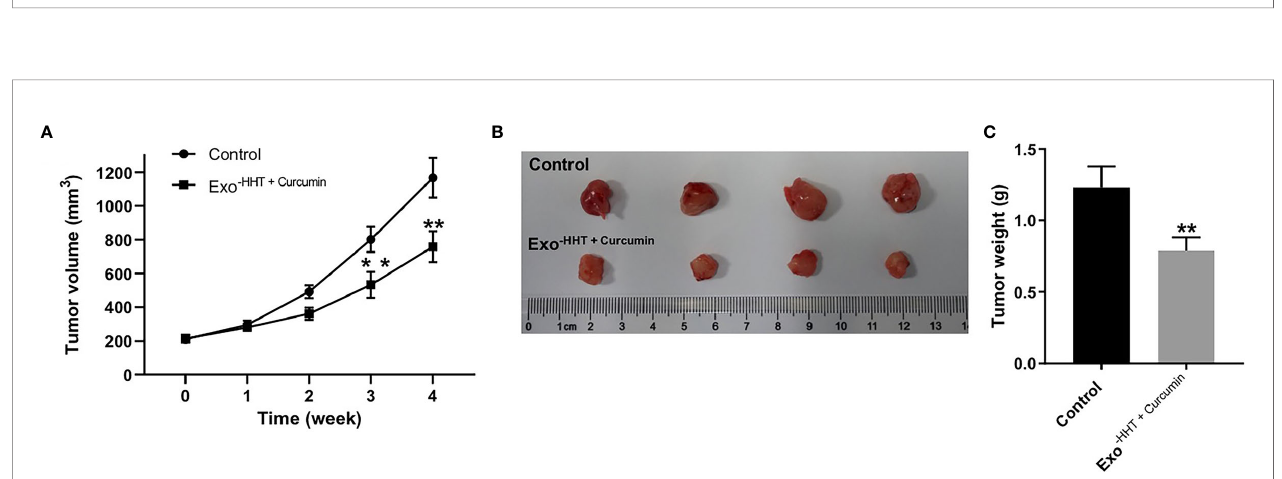
FIGURE 6 | Raji/combination exosomes inhibits the angiogenesis of HUVECs. HUVECs were co-cultured with exosomes obtained from Raji cells that were treated with HHT or/and curcumin or treated with HHT, curcumin and VEGF. (A) The tube formation ability of HUVECs was detected by tube formation assay. Scale bar, 100 m m. (B) Expression levels of Angiogenin-1, MMP2, MMP9 and p-Akt in HUVECs were detected with western blotting. (C – F) The relative expressions of Angiogenin-1, MMP2 and MMP9 in cells were quanti fi ed via normalization to b -actin. The relative expression of p-Akt in cells were quanti fi ed via normalization to Akt. *P < 0.05, **P <